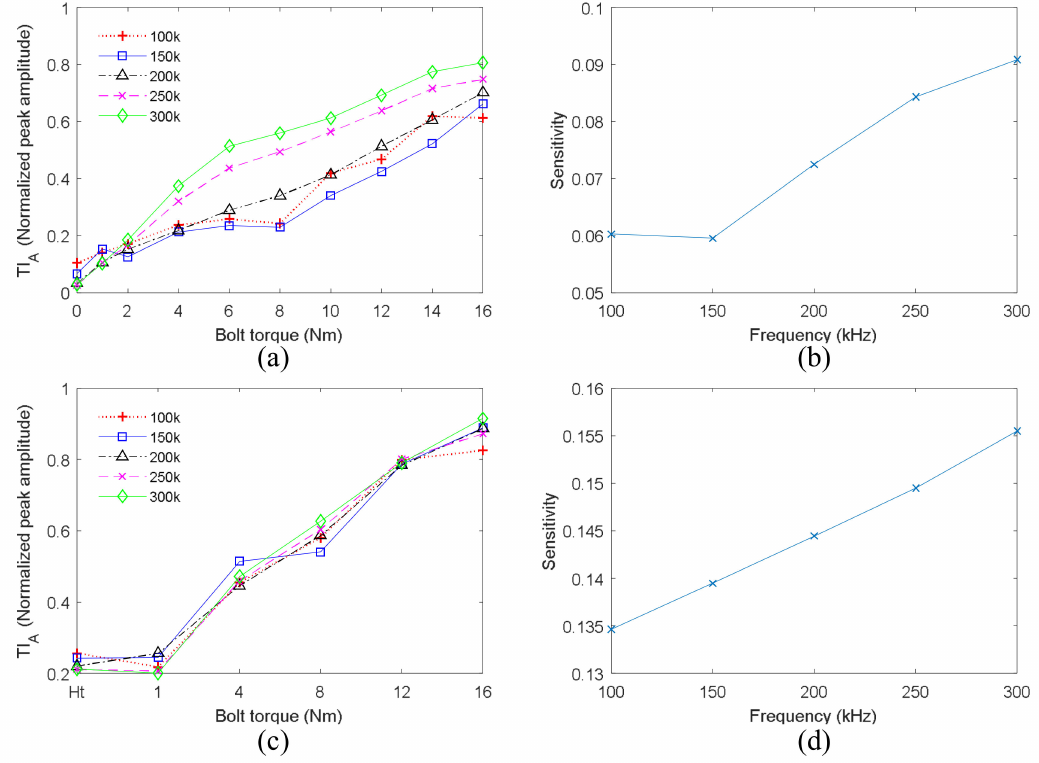
Figure 14. The effect of frequency on VTR method ( a ) results of the single bolt structure; ( b ) detection sensitivity for the single bolt structure; ( c ) results of four-bolt structure; ( d ) detection sensitivity for the four-bolt